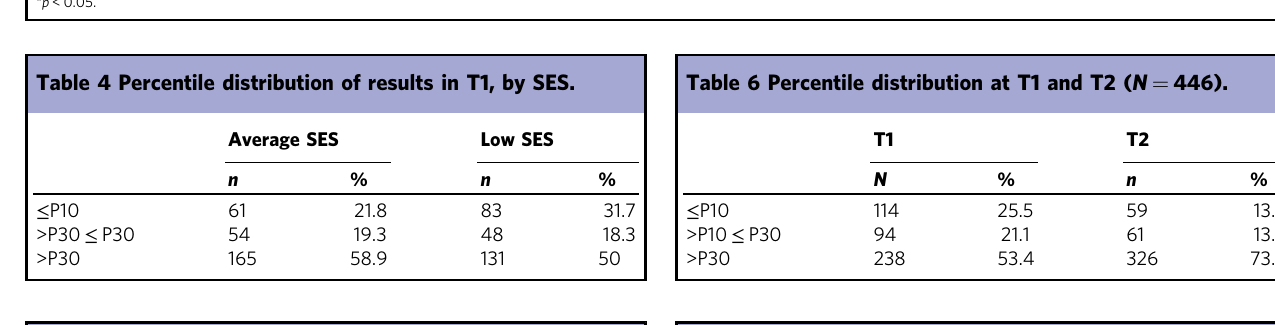
Table 5 Accuracy in TRL at T1 and T2, comparing low and average SES.